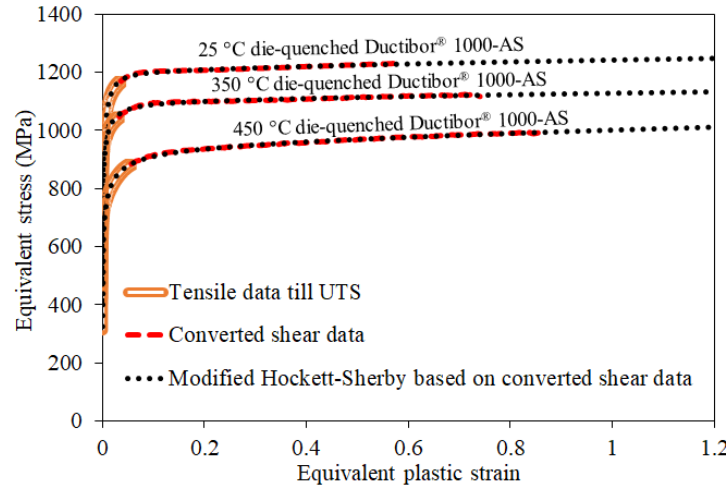
Figure A3. The extrapolated hardening curves corresponding to the modified Hockett-Sherby model based upon the tensile and converted shear data for various die-quenched conditions of Ductibor ® 1000-AS. The tensile and shear results correspond to the tests with the TD-oriented major principal stress. Figure A4 displays the predicted engineering stress-strain response of the three hot- stamped conditions along the TD in the FE simulations. The predictions are consistent with the measured data for all material conditions. Such agreement serves to validate the obtained hardening curves.